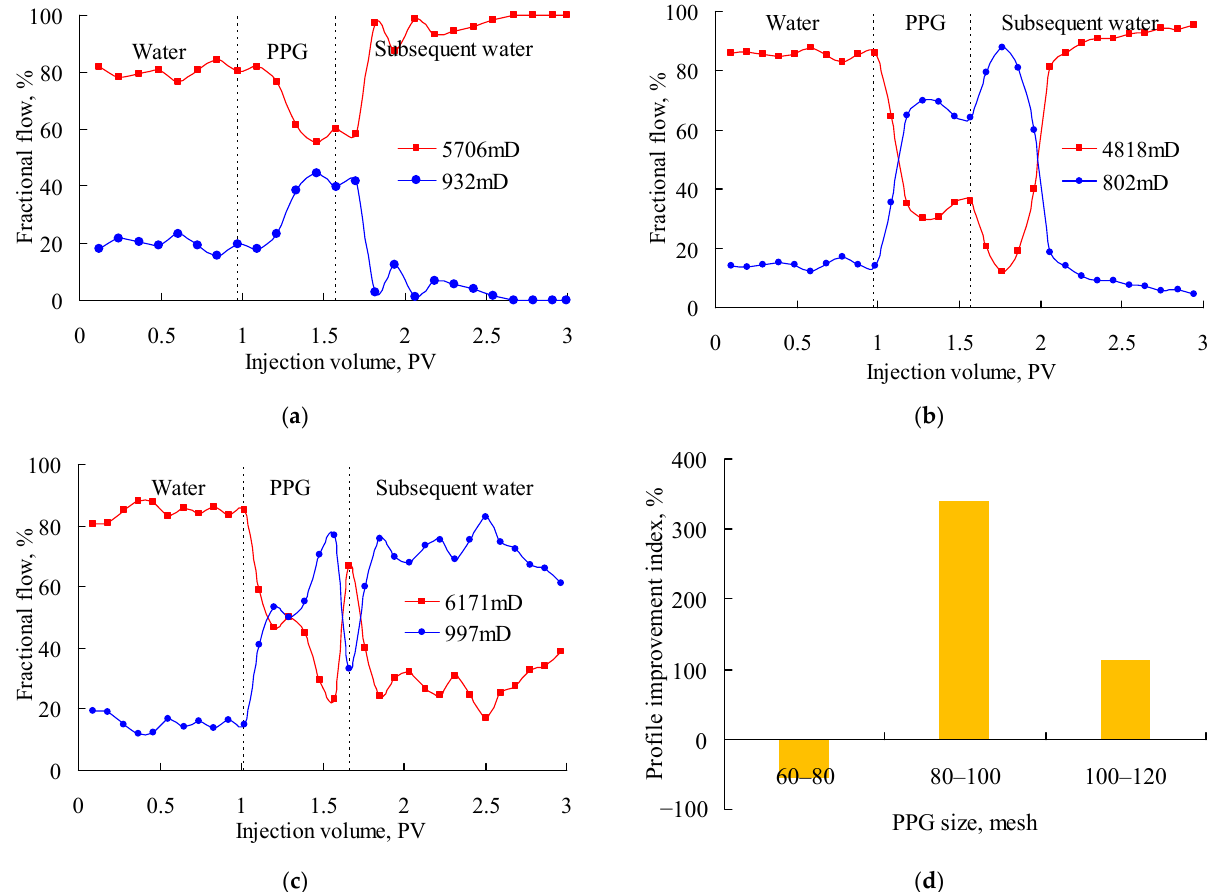
Figure 5. Fractional flow of parallel sand packs with permeability ratio of about 6 after injecting the PPG (12–16 Pa). ( a ) 60–80 mesh; ( b ) 100–120 mesh; ( c ) 80–100 mesh; ( d ) profile improvement index.